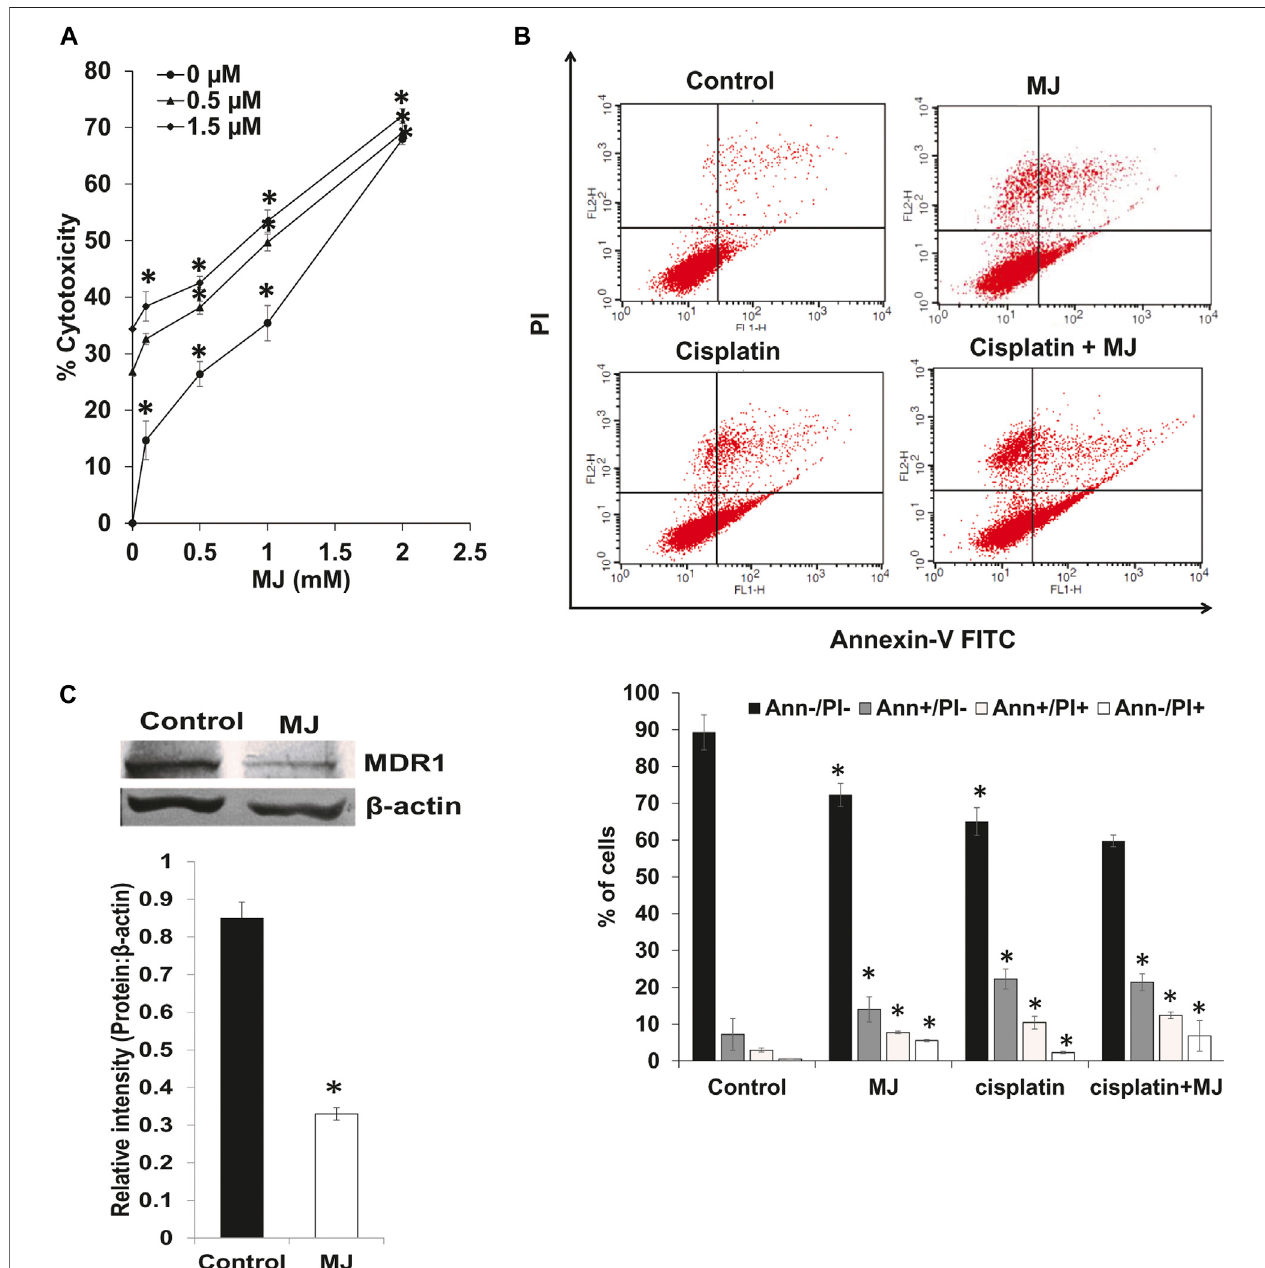
FIGURE 5 | MJ enhances chemosensitivity of tumor cells. Tumor cells (1 × 10 5 cell/ml) cells were incubated in medium alone or containing MJ in the presence or absence of cisplatin for 18 h followed by estimation of the cytotoxicity (A) as described in the materials and methods. Tumor cells (1 × 10 5 cell/ml) incubated in medium alone or containing MJ in the presence or absence of cisplatin for 18 h were analyzed for apoptotic cell population by fl ow cytometry using Annexin-V/PI staining as described in the materials and methods. The fl ow cytometric image (B) is from a representative experiment out of three independent experiments with similar results. The bar diagram accompanying the fl ow cytometric images depicts the mean ± SD of the % of cells. * p < 0.05 vs. respective control. In a parallel set of experiments, the cell lysates of control and MJ-treated tumor cells (1 × 10 5 cell/ml) were analyzed for expression of MDR1. Bands (C) are from a representative experiment out of three with a similar pattern. The accompanying bar diagrams are densitometric analysis of the bands (C) . Values shown are mean ± SD. * p < 0.05 vs. respective control.